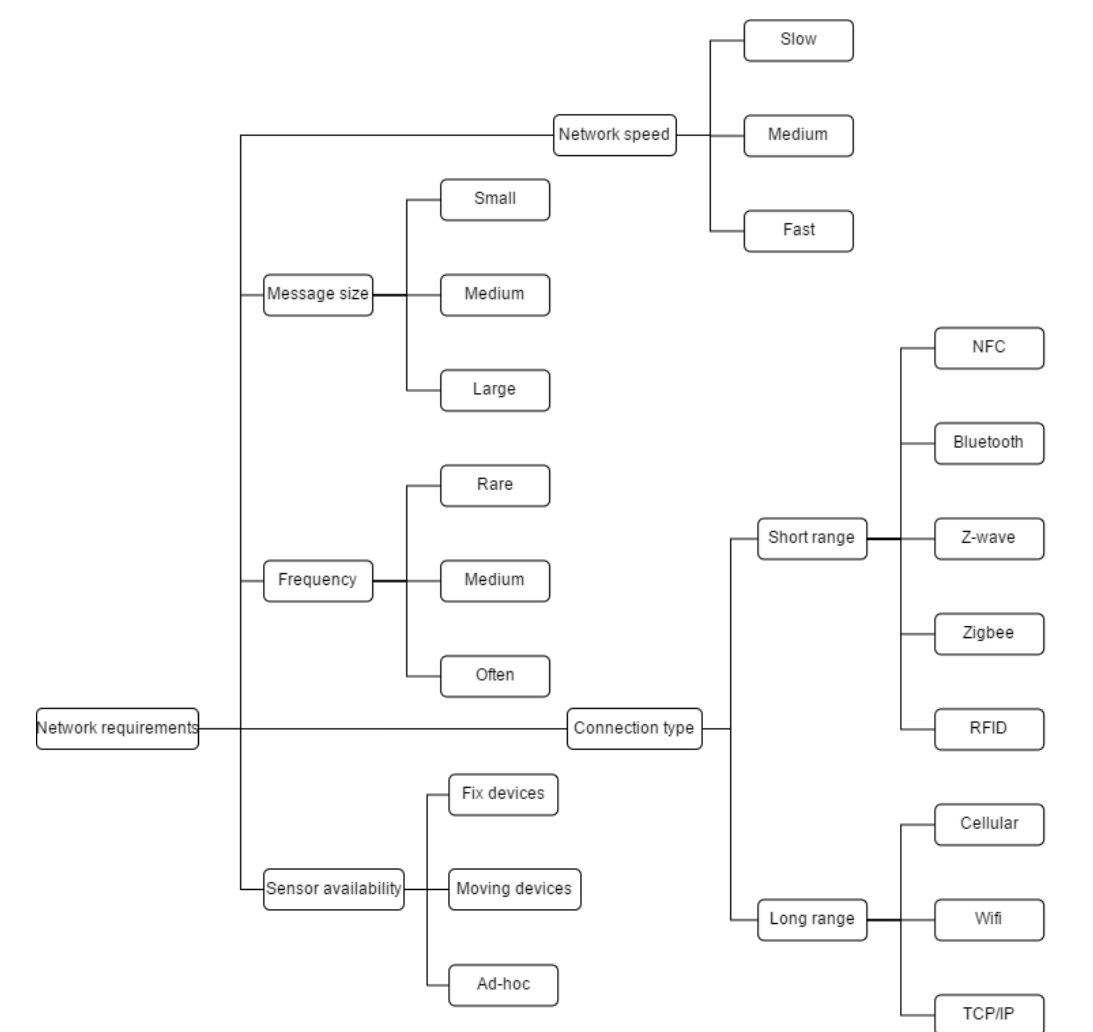
Figure 4. The Network requirements category of the